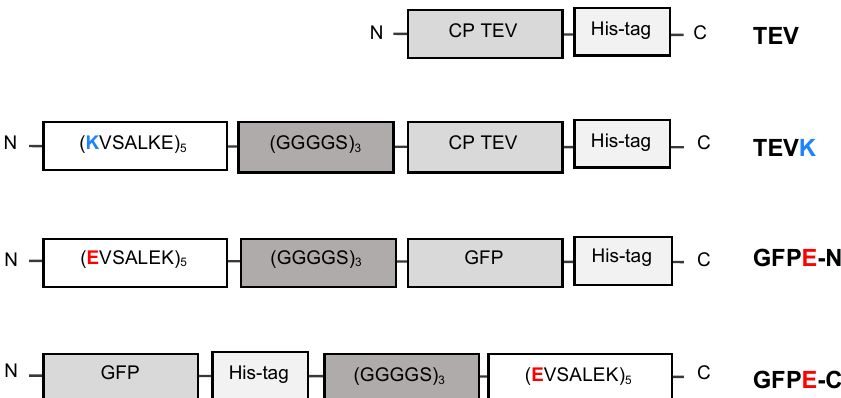
Figure 1. Graphical representation of viral coat protein (CP) and antigens. TEV: native Tobacco etch virus CP; TEVK: Tobacco etch virus CP having a K-coil motif; GFPE-N: green fluorescent protein (GFP) having an E-coil motif at N-terminus; GFPE-C: GFP having an E-coil motif at C-terminus. His-tag: six histidine tag; (GGGGS) 3 : flexible linker.